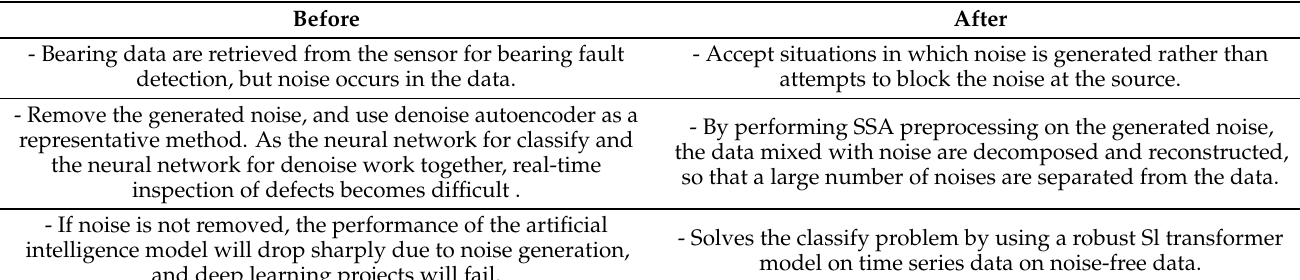
Table 7. Before and after comparison with SSA-Sl transformer introduction